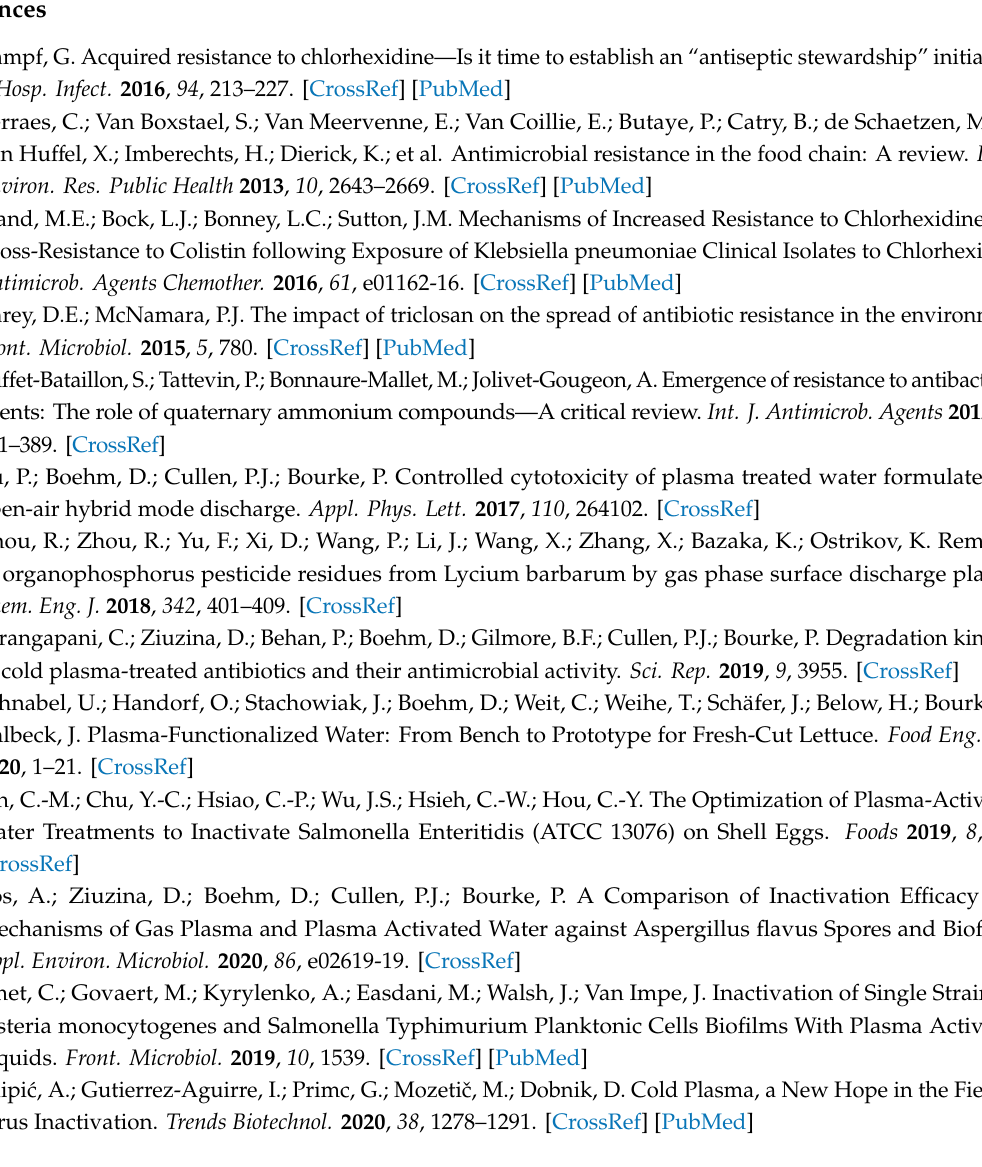
Table S1: Microbial inactivation of E. coli and S. aureus at 30 and 60 min contact time, treated with PAW or PAS stored at di ff erent temperatures for up to 18 months. Table represents averages of 2 independent plasma treatments (Set 1 and 2), Table S2: Microbial inactivation of E. coli and S. aureus at 30 and 60 min contact time, treated with PAW or PAS stored at di ff erent temperatures for up to 6 months. Table represents 1 independent plasma treatment (Set 3), Table S3: Microbial inactivation of E. coli and S. aureus at 30 and 60 min contact time, treated with PAW or PAS stored at di ff erent temperatures for up to 3 months. Table represents 1 independent plasma treatment (Set